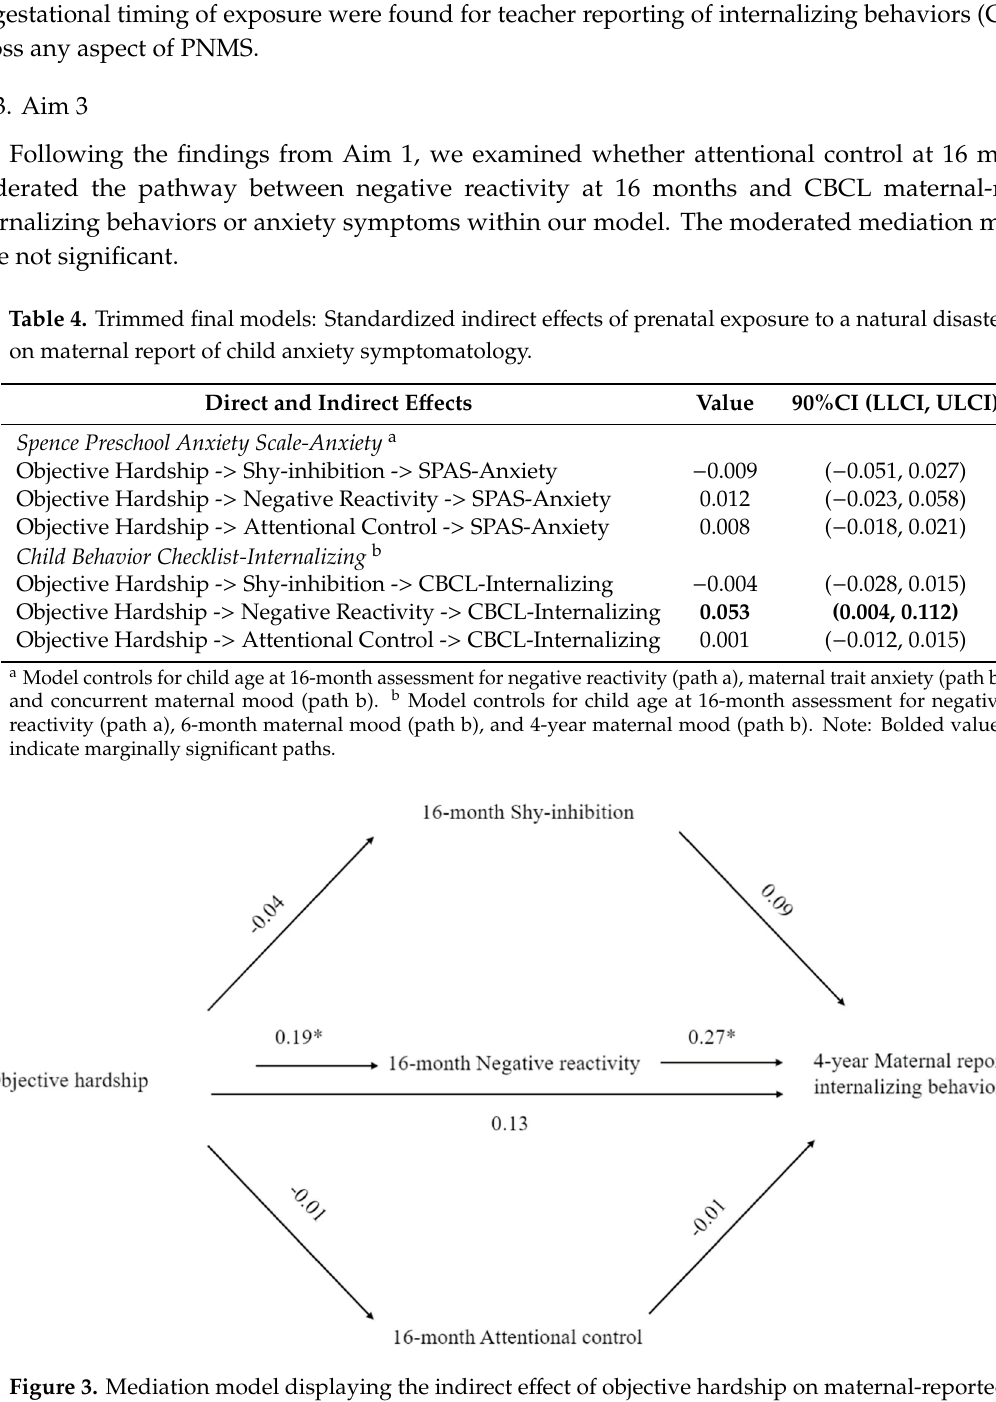
Figure 3. Mediation model displaying the indirect effect of objective hardship on maternal-reported child internalizing behaviors via negative reactivity at 16 months. All values are standardized beta coefficients. ** p < 0.01, * p < 0.05, ^ p <